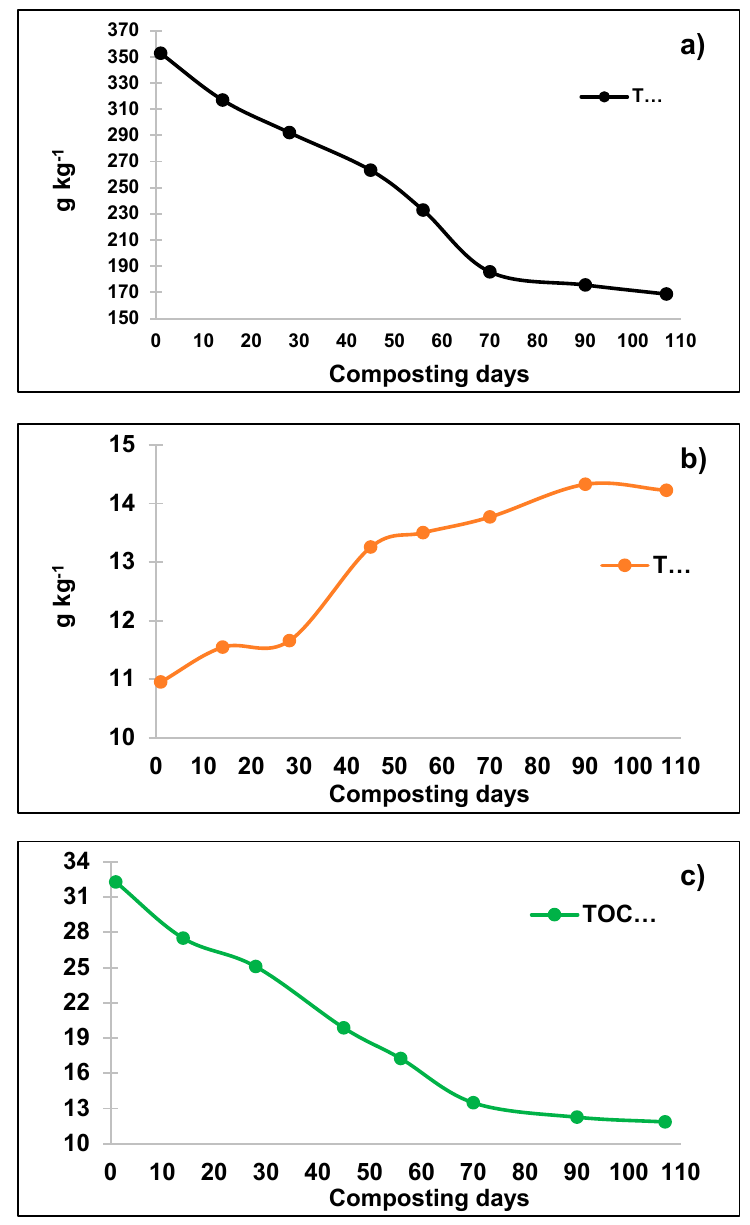
Figure 3. Changes in: ( a ) TOC and ( b ) TN and ( c ) TOC/TN during the composting of MSW (markers: measured values; lines: mean values).